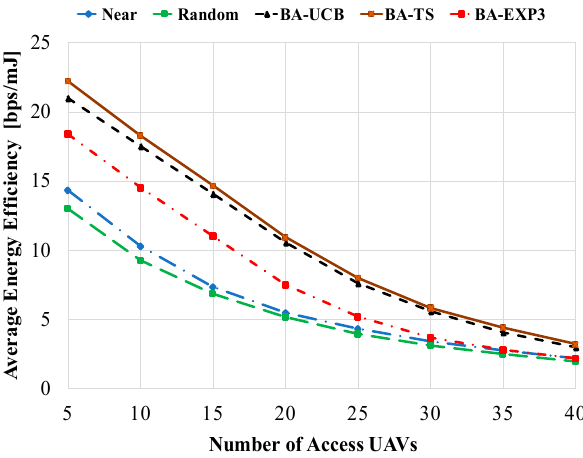
Figure 7. Average energy efficiency against the number of access UAVs using gateway UAVs of 20 and a beam-width of 60°.